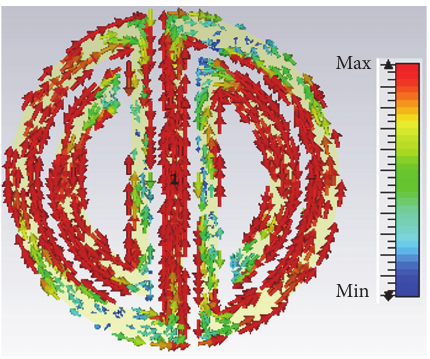
Figure 3: The surface current distribution at 10.75 GHz.